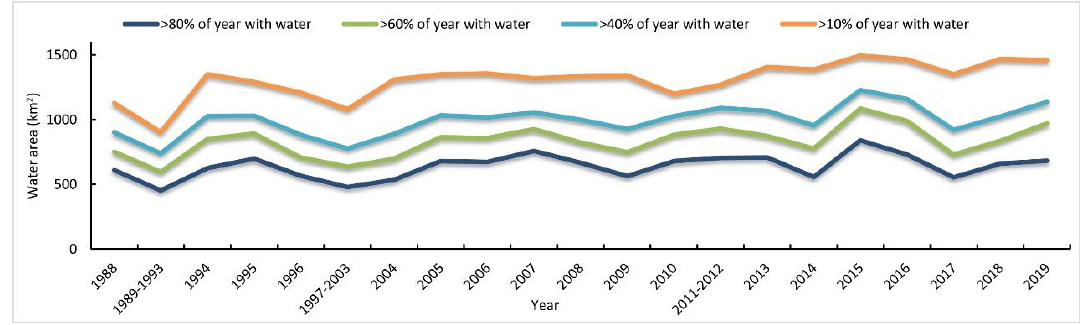
Figure 4. Cumulative water area of all pixels in Sri Lanka with various water occurrence frequency thresholds of the year ≥ 10%, ≥40%, ≥60%, and ≥80%, respectively.